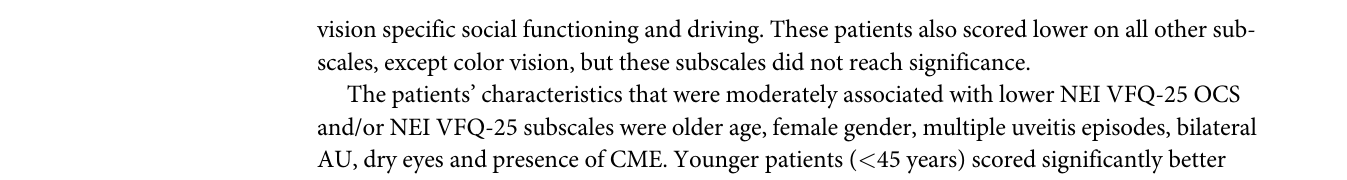
vision specific social functioning and driving. These patients also scored lower on all other sub- scales, except color vision, but these subscales did not reach significance. and/or NEI VFQ-25 subscales were older age, female gender, multiple uveitis episodes, bilateral AU, dry eyes and presence of CME. Younger patients ( < 45 years) scored significantly better